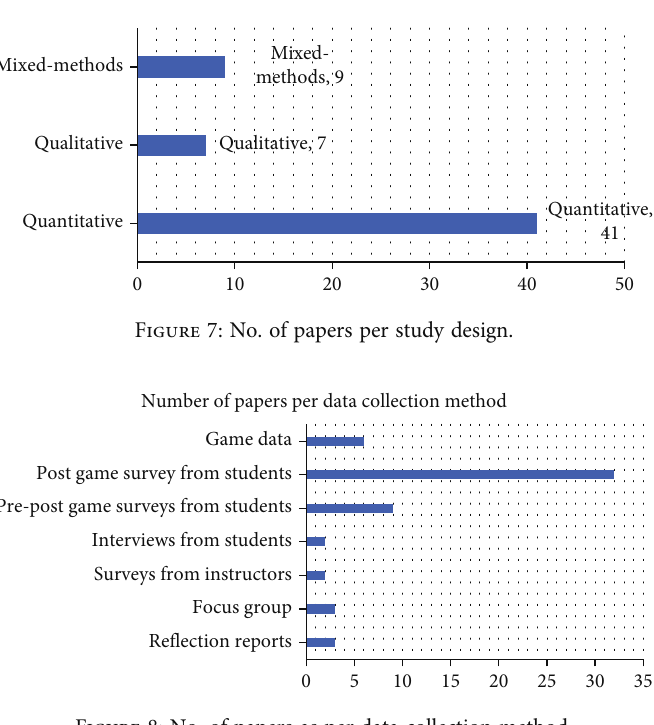
Figure 8: No. of papers as per data collection method.